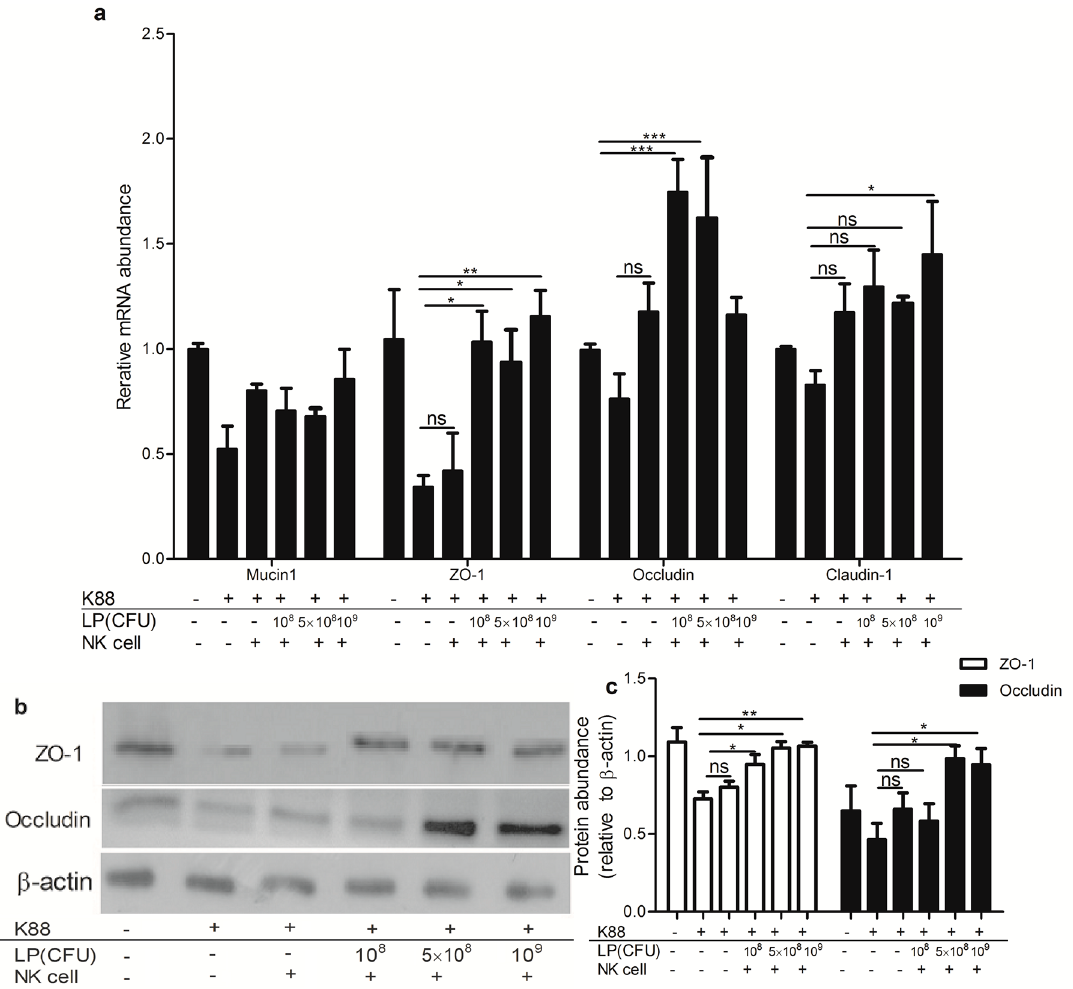
Figure 5. NK cells stimulated by Lactobacillus plantarum (LP) increased expression of tight junction proteins in NCM460 cells challenged with ETEC K88. NCM460 cell monolayers were untreated or treated with 10 8 CFU/mL ETEC K88 for 2 h, then NK cells stimulated or not by LP (10 8 , 5 × 10 8 or 10 9 CFU/mL) were added to ETEC K88-infected NCM460 cells and co-cultured for another 4 h. NCM460 cells were collected and the expressions of tight junctions were analyzed. ( a ) Relative expression of mucin1, ZO - 1, occludin and claudin-1 mRNA; ( b ) Western blots of the ZO-1 and occludin proteins. Equal protein loading was confirmed by analysis of β -actin in the protein extracts. ( c ) The ratios of ZO-1 and occludin to β -actin. Similar results were obtained from 3 independent experiments. Data are means ± SEM. * p < 0.05, ** p < 0.01, *** p < 0.001, ns: not significant. ZO-1, zonula occluden-1.